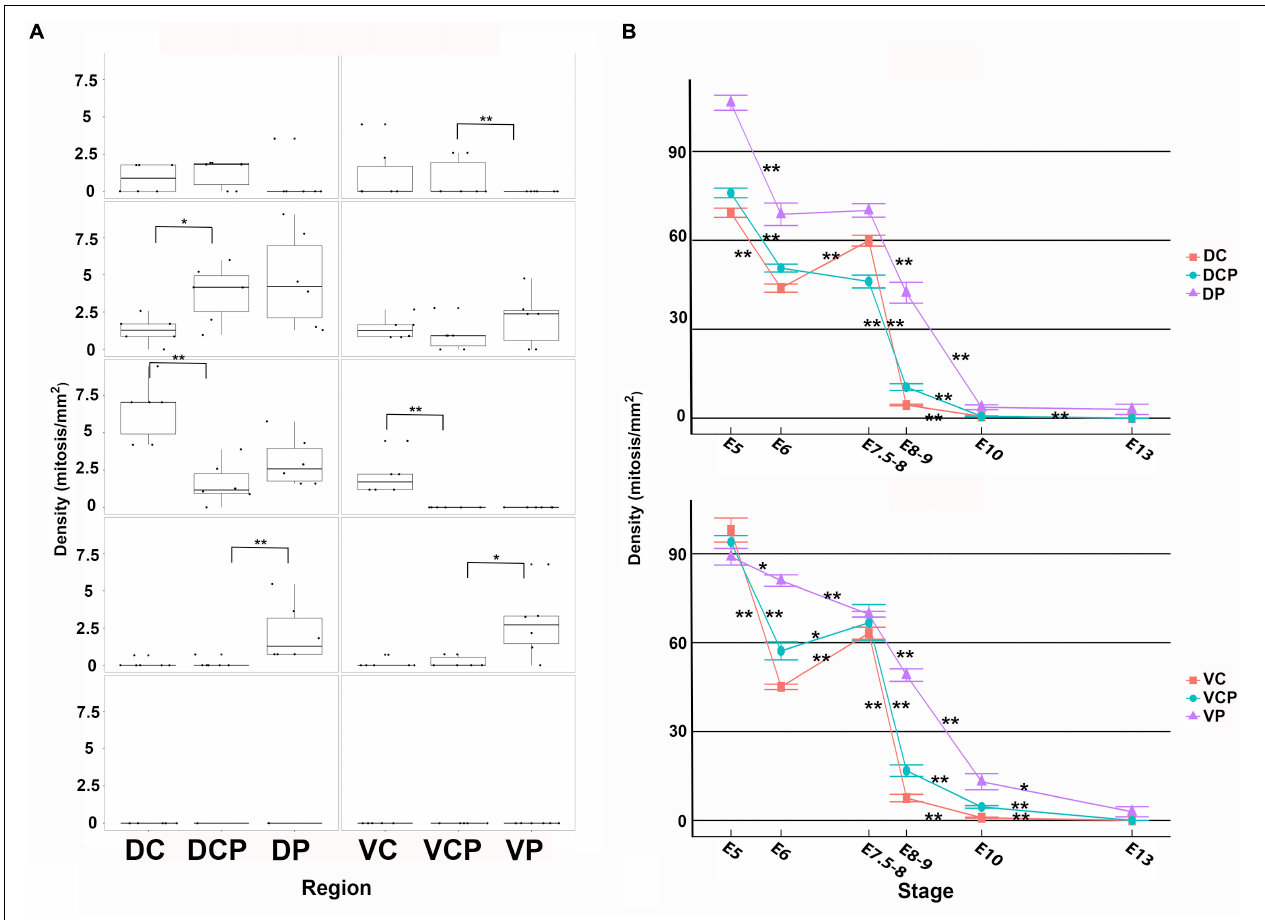
FIGURE 11 | Density values non-apical (A) and apical (B) mitoses in the developing retina of C. coturnix. For each retinal region, boxplots of all samples are shown with the average, median, interquartile, and outliers. Notice that at early stages the non-apical mitoses were mainly concentrated in the dorsal retina and at E8-9, they were mainly restricted to the Dp and Vp sectors. From this stage onwards, non-apical mitoses disappeared from the entire retina. Apical mitoses were almost absent from E8-9 onward in the Dc, Dcp, Vc, and Vcp sectors. The density values were very low in the Dp and Vp sectors at E13. Data are expressed as means ± s.e.m. Statistical significance is indicated by asterisks (* p < 0.05, ** p <